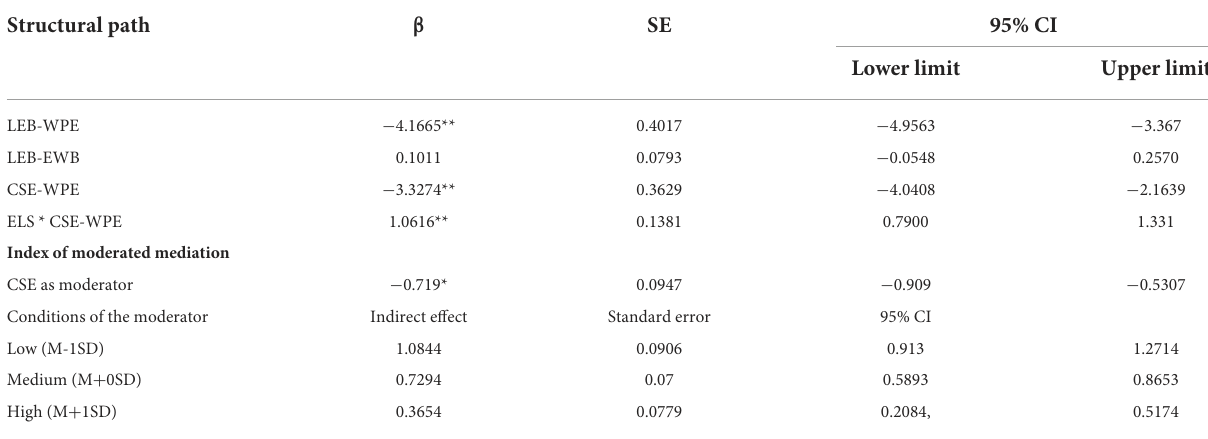
TABLE 6 Regression results for the conditional indirect